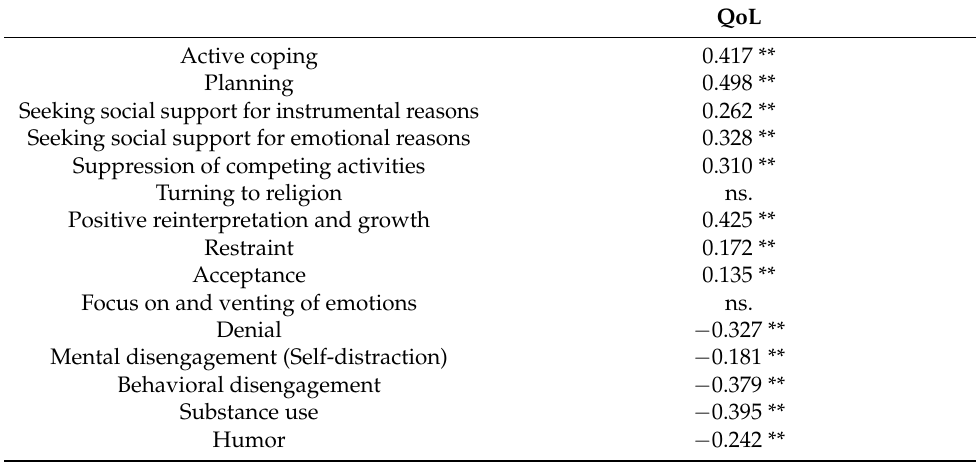
Table 4. Pearson’s product-moment correlation coefficients between QoL and coping styles.